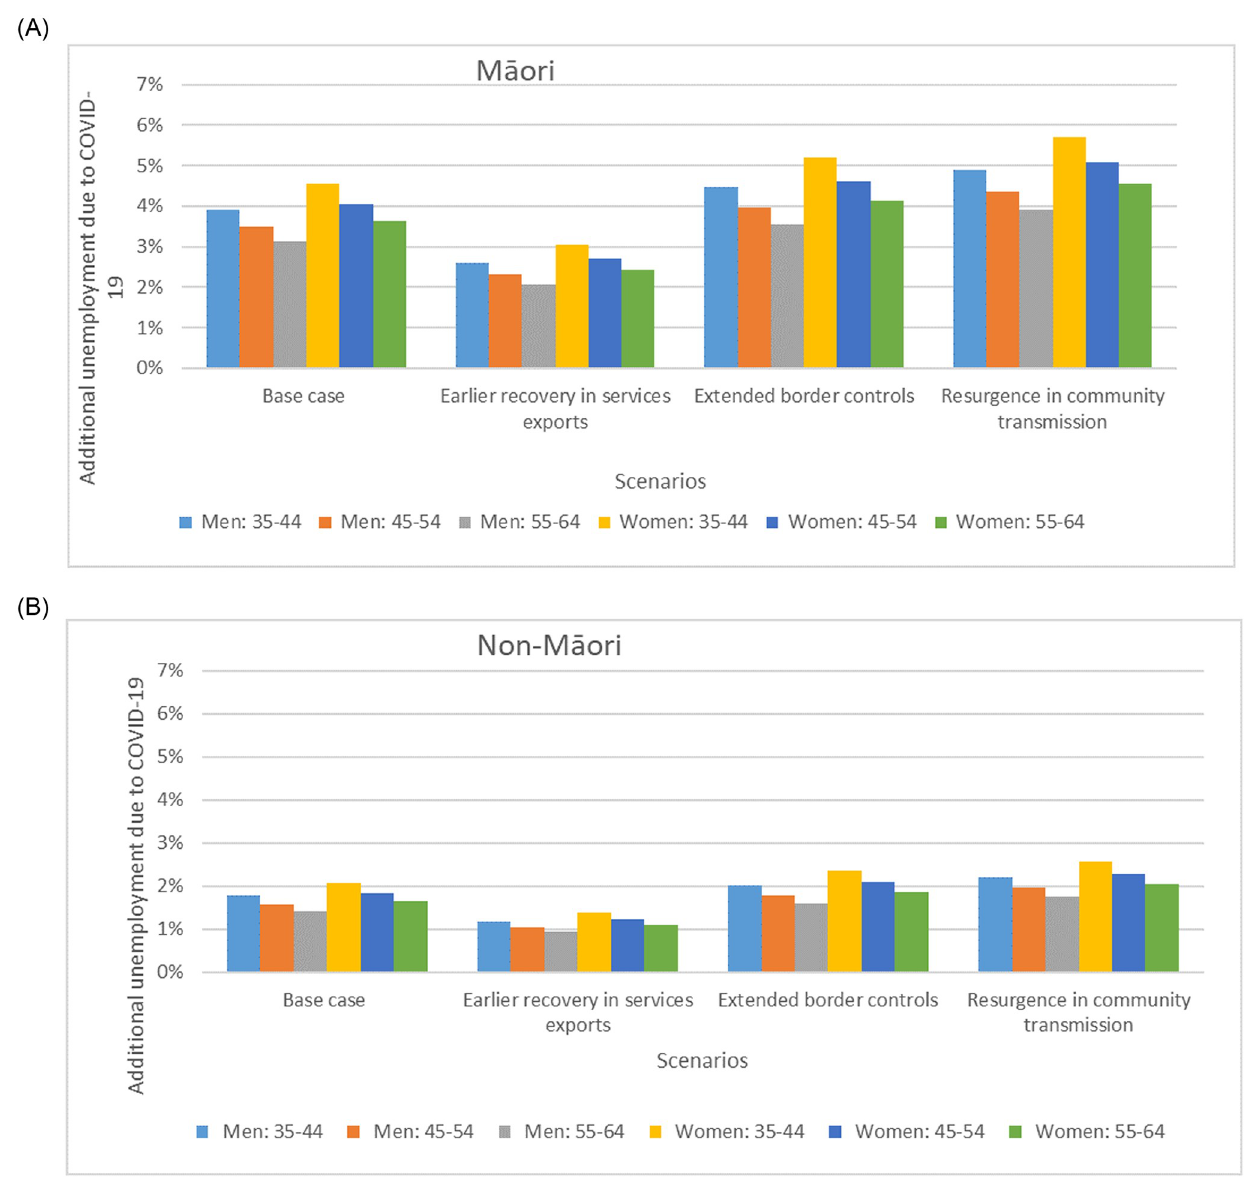
Fig 1. Scenarios around the COVID-19 pandemic related additional absolute unemployment rates in 2021 used in the BODE 3 CVD model by age, sex and ethnicity in NZ a,b,c,d . a These unemployment rates were the differences in the projected unemployment rates between having the COVID-19 pandemic (Scenarios in Table 1) and having not had the COVID-19 pandemic (Baseline Scenario in Table 1). They were also adjusted by the unemployment rates by age, sex and ethnicity in 2010–2014 reported by the NZ Government. b All unemployment rates followed a log-normal distribution with an assumed 20% standard deviation (due to all health responses and economic outlooks being highly uncertain). c We only extracted unemployment rates for these age- groups as they are in typical working age-groups, and are potentially impacted by the CVD burden. But we acknowledge this limitation further in the Discussion. d The age-groups in this Table do not exactly match the ones in Table 2, but we used the closest age-group for RR and additional unemployment rate in our model. Note that in 2021, unemployment rates are similar across scenarios (see Table 1). Furthermore, in the Treasury economic models, the projected unemployment levels take into account the impact from GDP and other services such as impacts from the continued loss of international students and international tourists.